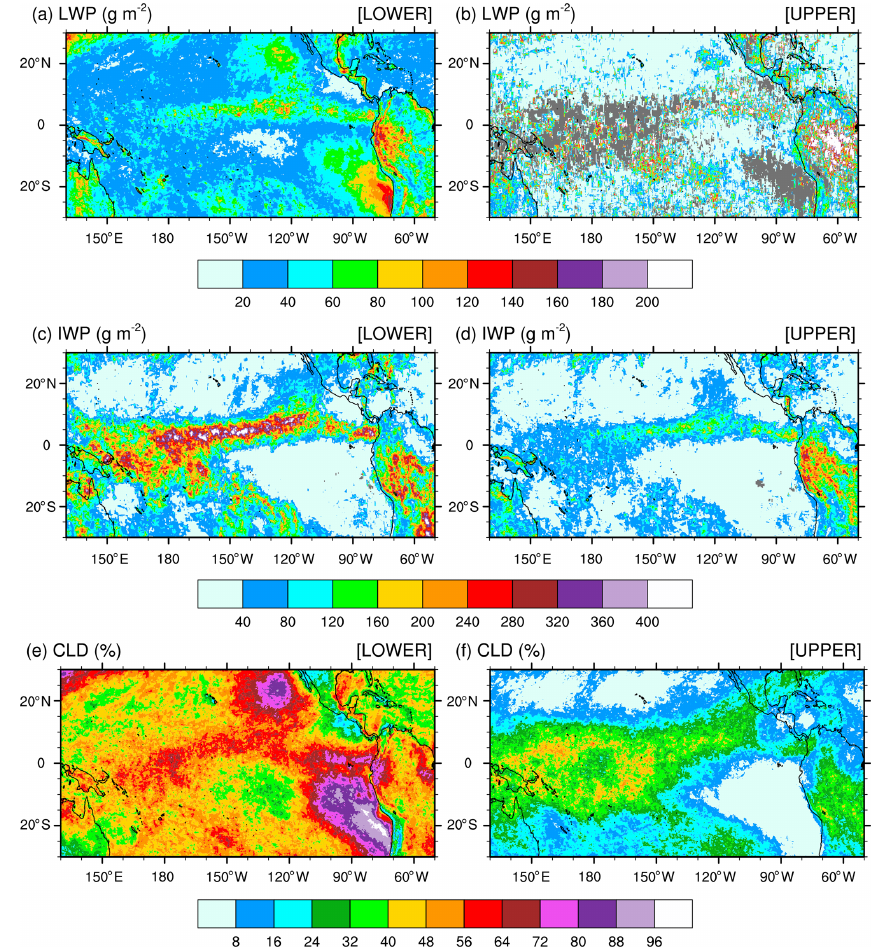
Figure 4. (a, b) Monthly-mean cloud liquid water path (LWP), (c, d) cloud ice water path (IWP), and (e, f) cloud fraction (CLD) over the tropical Pacific Ocean for December 2015 from the Aqua satellite. Panels (a) , (c) , and (e) are for the lower cloud layer; panels (b) , (d) , and (f) are for the upper cloud